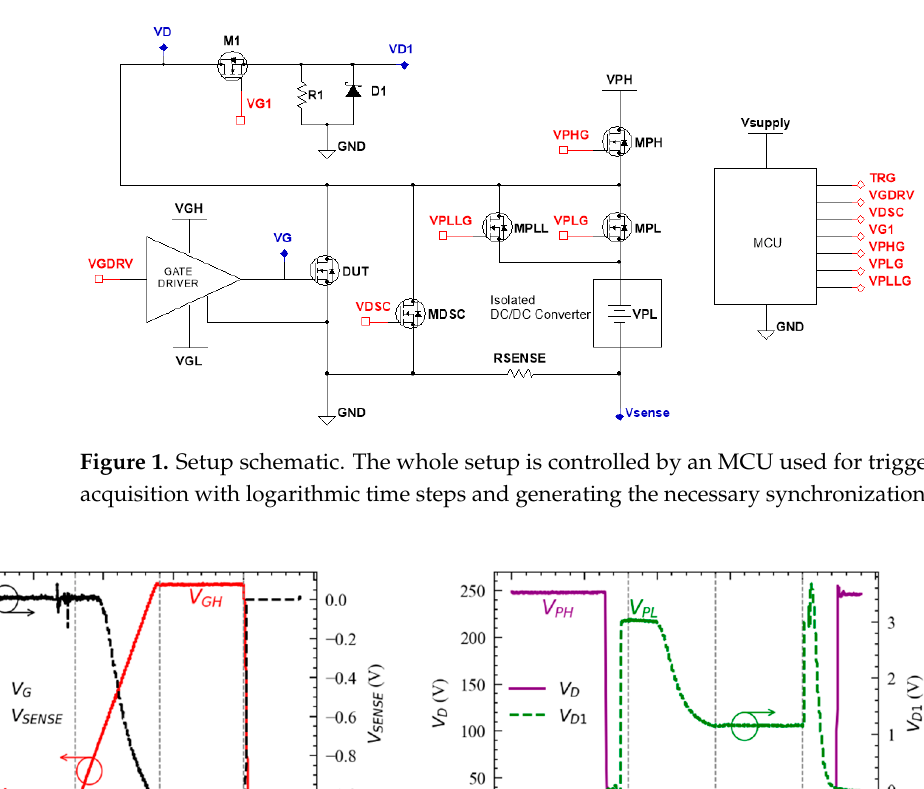
Figure 1. Setup schematic. The whole setup is controlled by an MCU used for triggering the DSO acquisition with logarithmic time steps and generating the necessary synchronization signals.